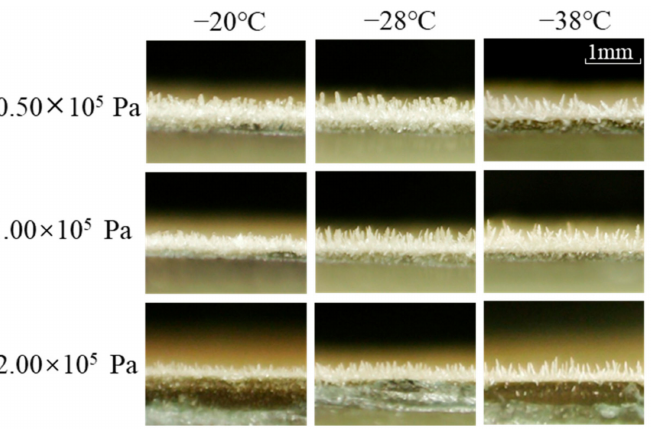
Figure 12. Frost crystal morphologies with working pressure around cooling surface under different temperatures of cooling surfaces at 10